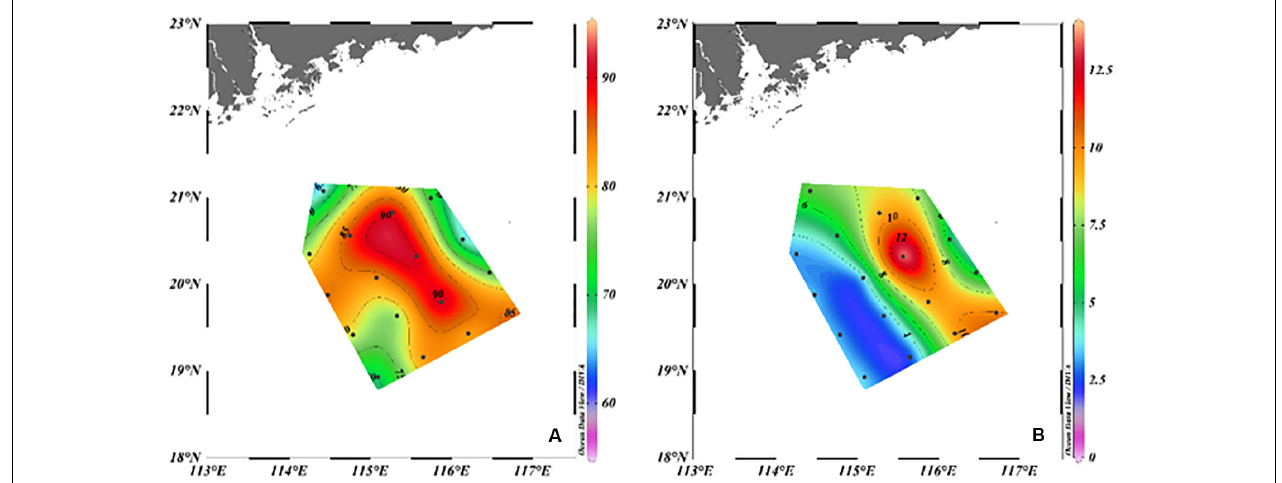
FIGURE 3 | Surface distribution of DOC ( µ mol L − 1 ) (A) and POC ( µ mol L − 1 ) (B) in June 2015.